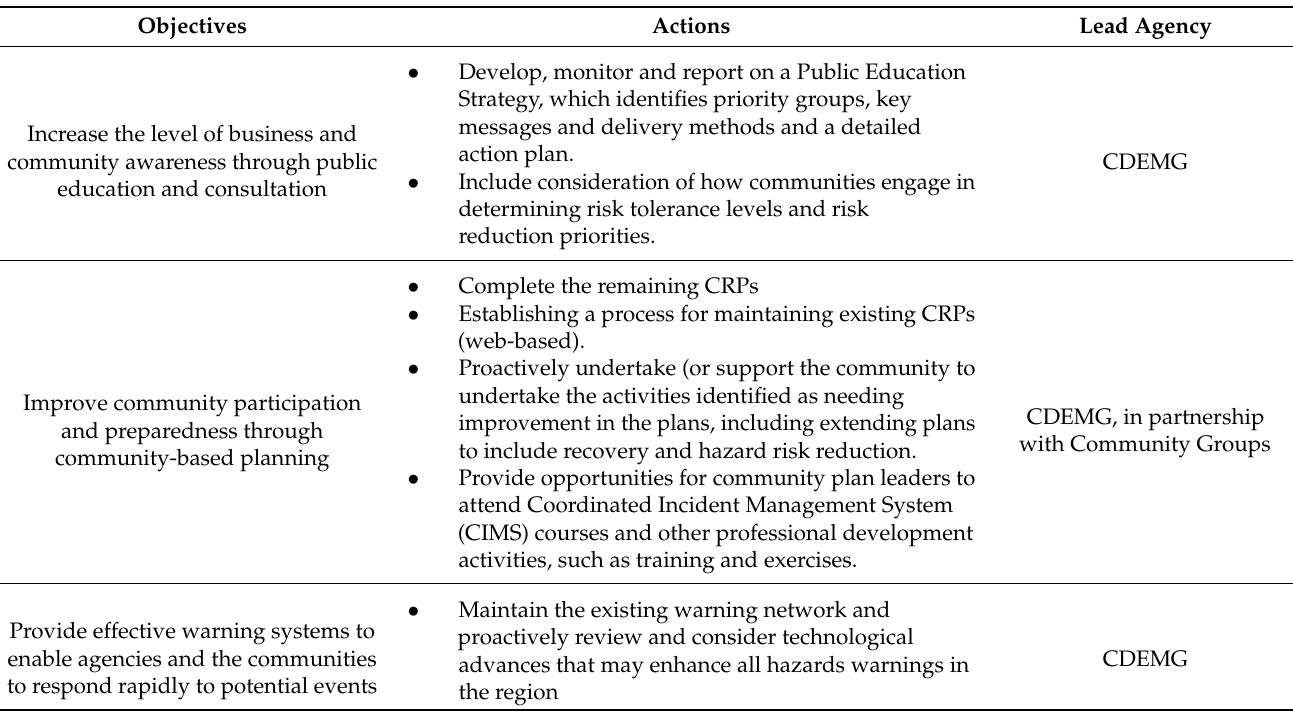
Table A1. Community response action plans in Northland (Source: Authors).